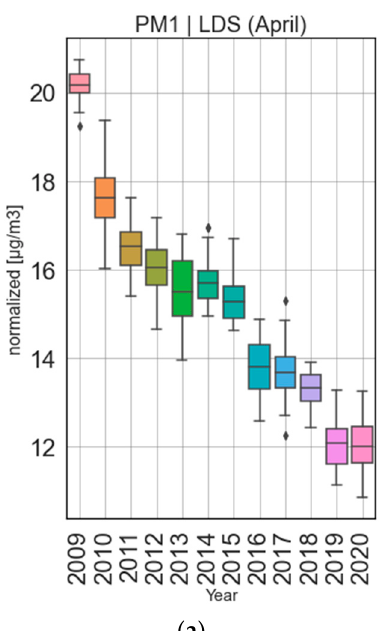
Figure 6. ( a ) Normalized medians for January and February (CS) during 2009–2020, ( b ) Normalized medians for June and July (NNS) during 2009–2020. The green line is PM 10 related to the respective right axis, while blue and orange are PM 1 and PM 2.5 mass concentrations respectively referred to the left axis. The horizontal lines present the lowest values for the axes respectively.